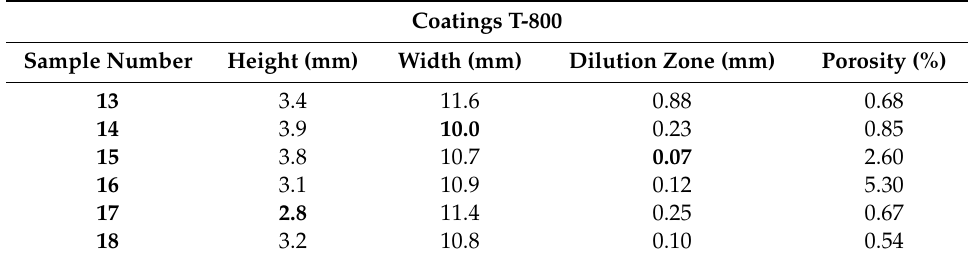
Table 4. Characteristic dimensions and porosity of T-800 coatings deposited with di ff erent LENS